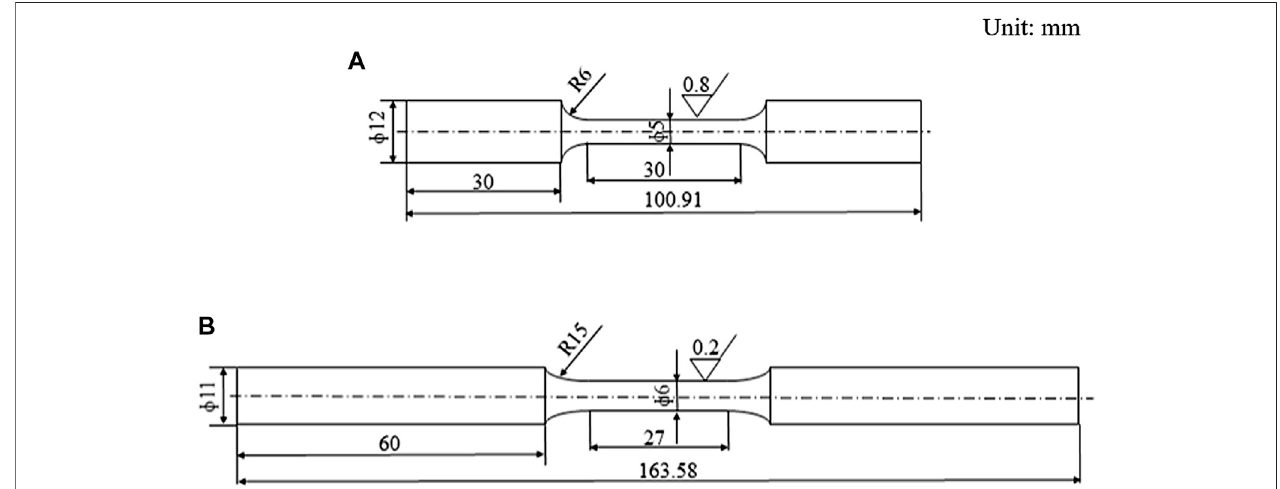
FIGURE 1 | Dimension diagram of the specimen, (A) mechanical test, (B) fatigue